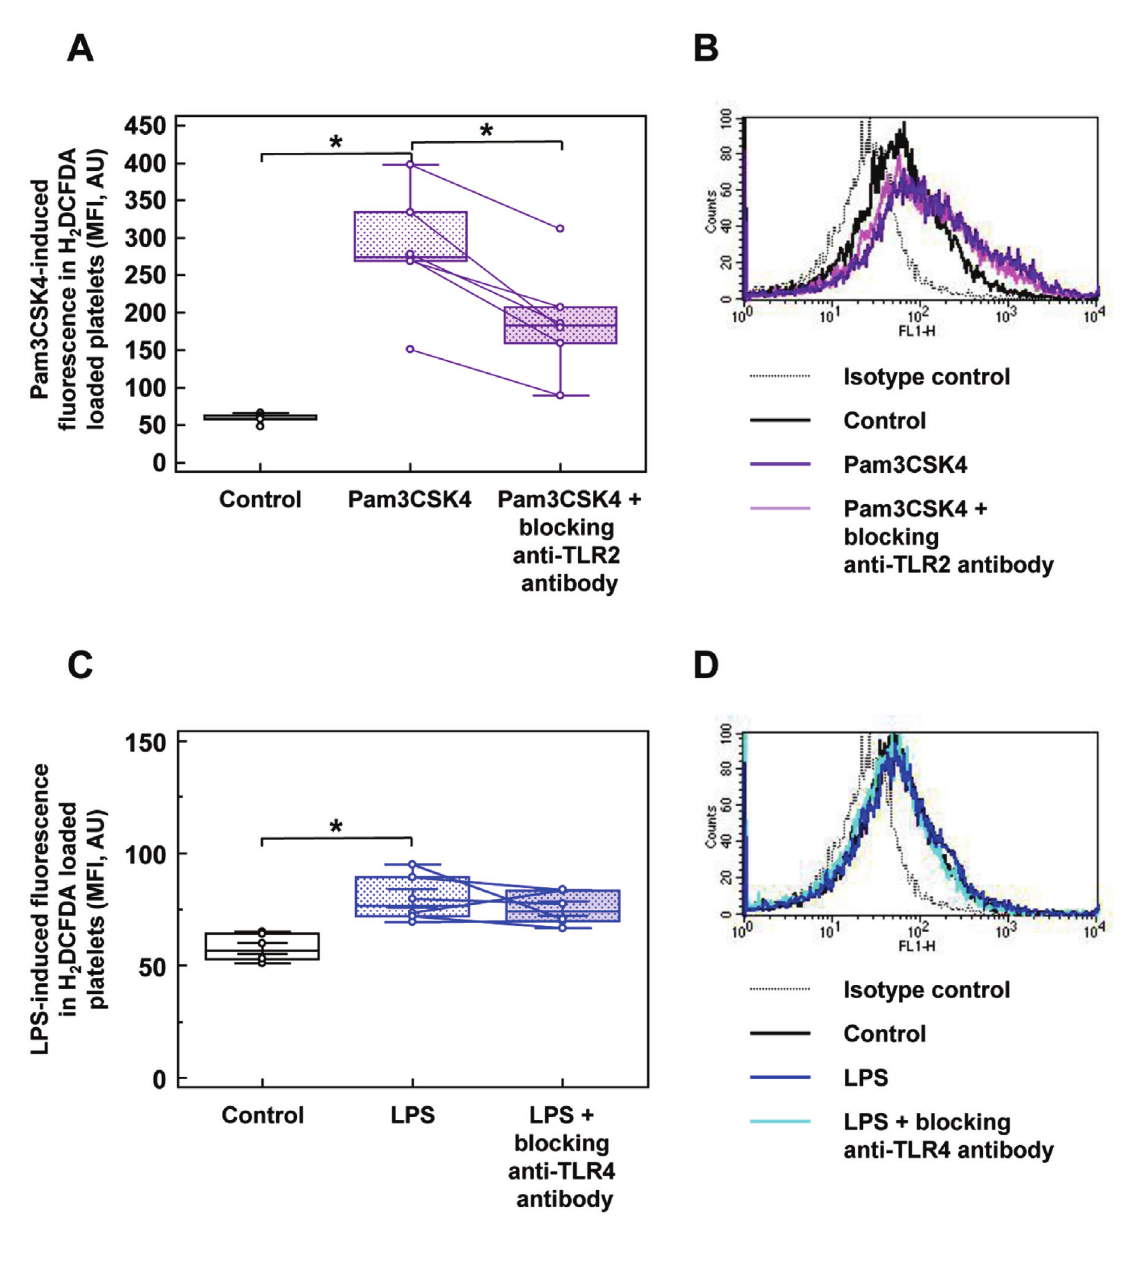
Fig.4 TLR2 and TLR4 activation evoke intracellular ROS production. The intracellular ROS production was measured in WP after stimulation with 15 µg/mLof Pam3CSK4 (A andB) and15µg/mLof LPS (C and D) . The datapresentedasbox-and-whiskerplots (AandC) demonstratethe changes of the single MFI values after TLR2 or TLR4 stimulation in the presence and absence of blocking antibodies. Data are presented as mean MFI (cid:3) SEM; n ¼ 6; (cid:4) p < 0.05; compared with control. The representative histograms of fl ow cytometry illustrate the shifts of mean fl uorescence peaks under corresponding stimulations (B and D) . Further methodological details are given in ► Supplementary Fig. S1 . LPS, lip- opolysaccharides; SEM, standard error of mean; TLR, toll-like receptor; WP, washed platelets.